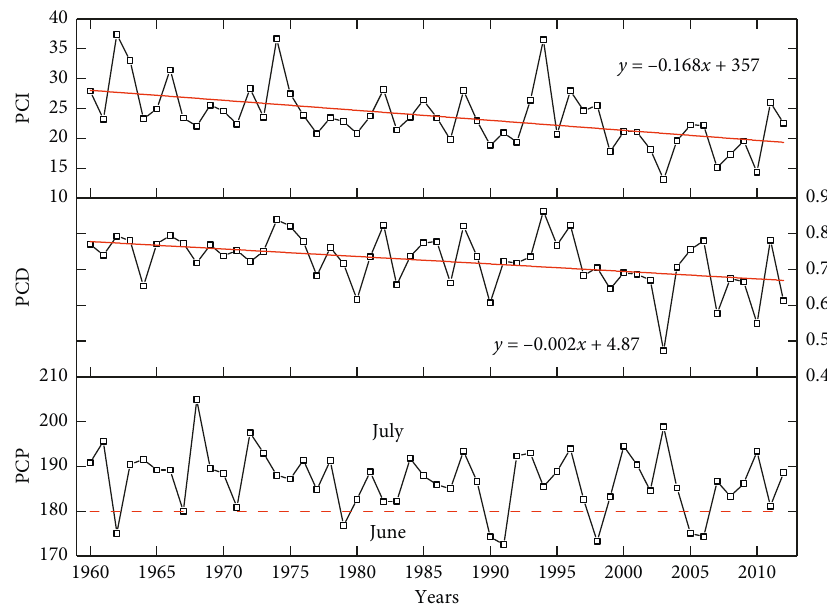
Figure 5: Time series of PCI, PCD, and PCP over the period of 1960–2012. The red solid line indicates the linear regression trend. The red dashed line means the boundary between the months June and July for the PCP. If the PCP is lower than 180, the maximum monthly precipitation appears in June. If the PCP ranges from 180 to 210, the maximum value appears in July. Table 4: Results of change point analysis for different series based on the Pettitt